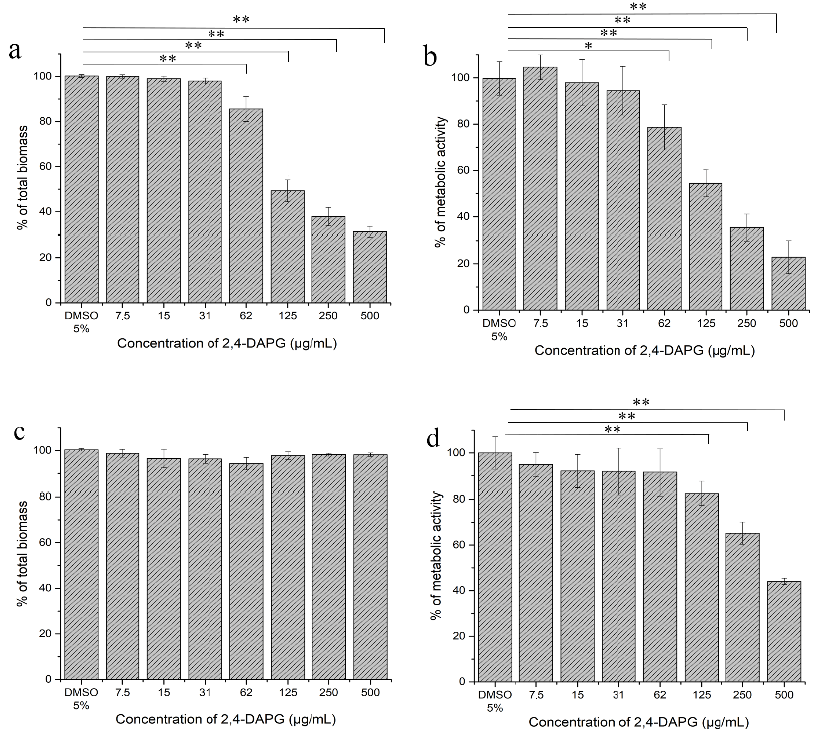
Figure 1. Influence of 2,4-DAPG on the C. albicans ATCC 10231 biofilm development ( a , b ) and on the mature biofilm ( c , d ). 2,4-DAPG action was estimated by measuring biofilm biomass ( a , c ) and metabolic activity of the biofilm-embedded cells ( b , d ). The y-axis represents percentages calculated with respect to the control sample. The means plus standard deviations of results from two independent experiments with three technical replicates are shown. Values that are significantly different from the values for “DMSO 5%” are indicated * p < 0.05, ** p < 0.01 (pair-sample Student’s t -test).